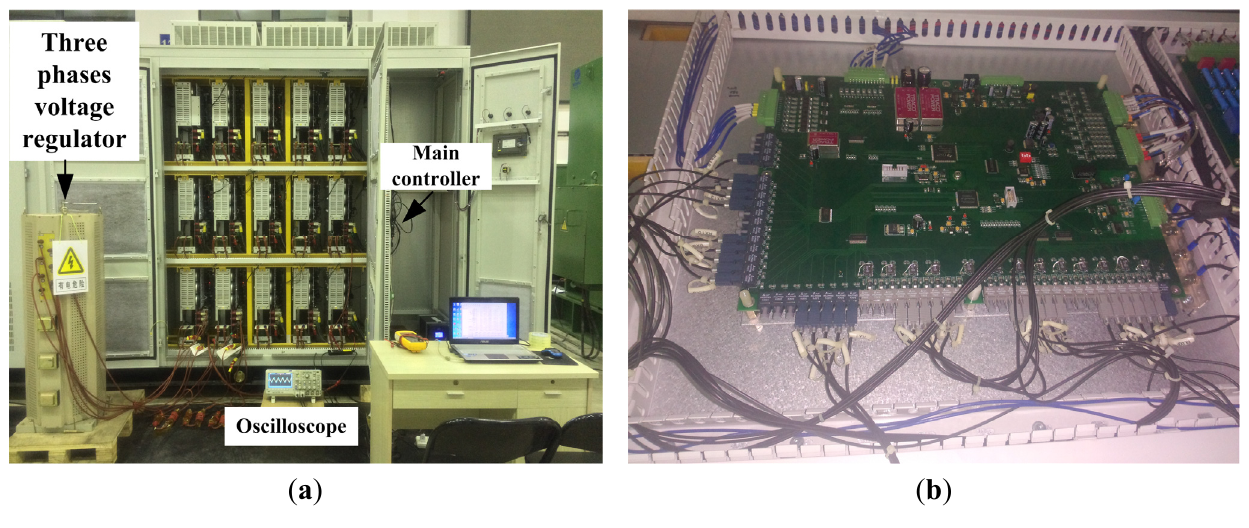
Figure 8. 2.5 MVA CHBML inverter: ( a ) inverter and major experimental devices; and ( b ) main controller.